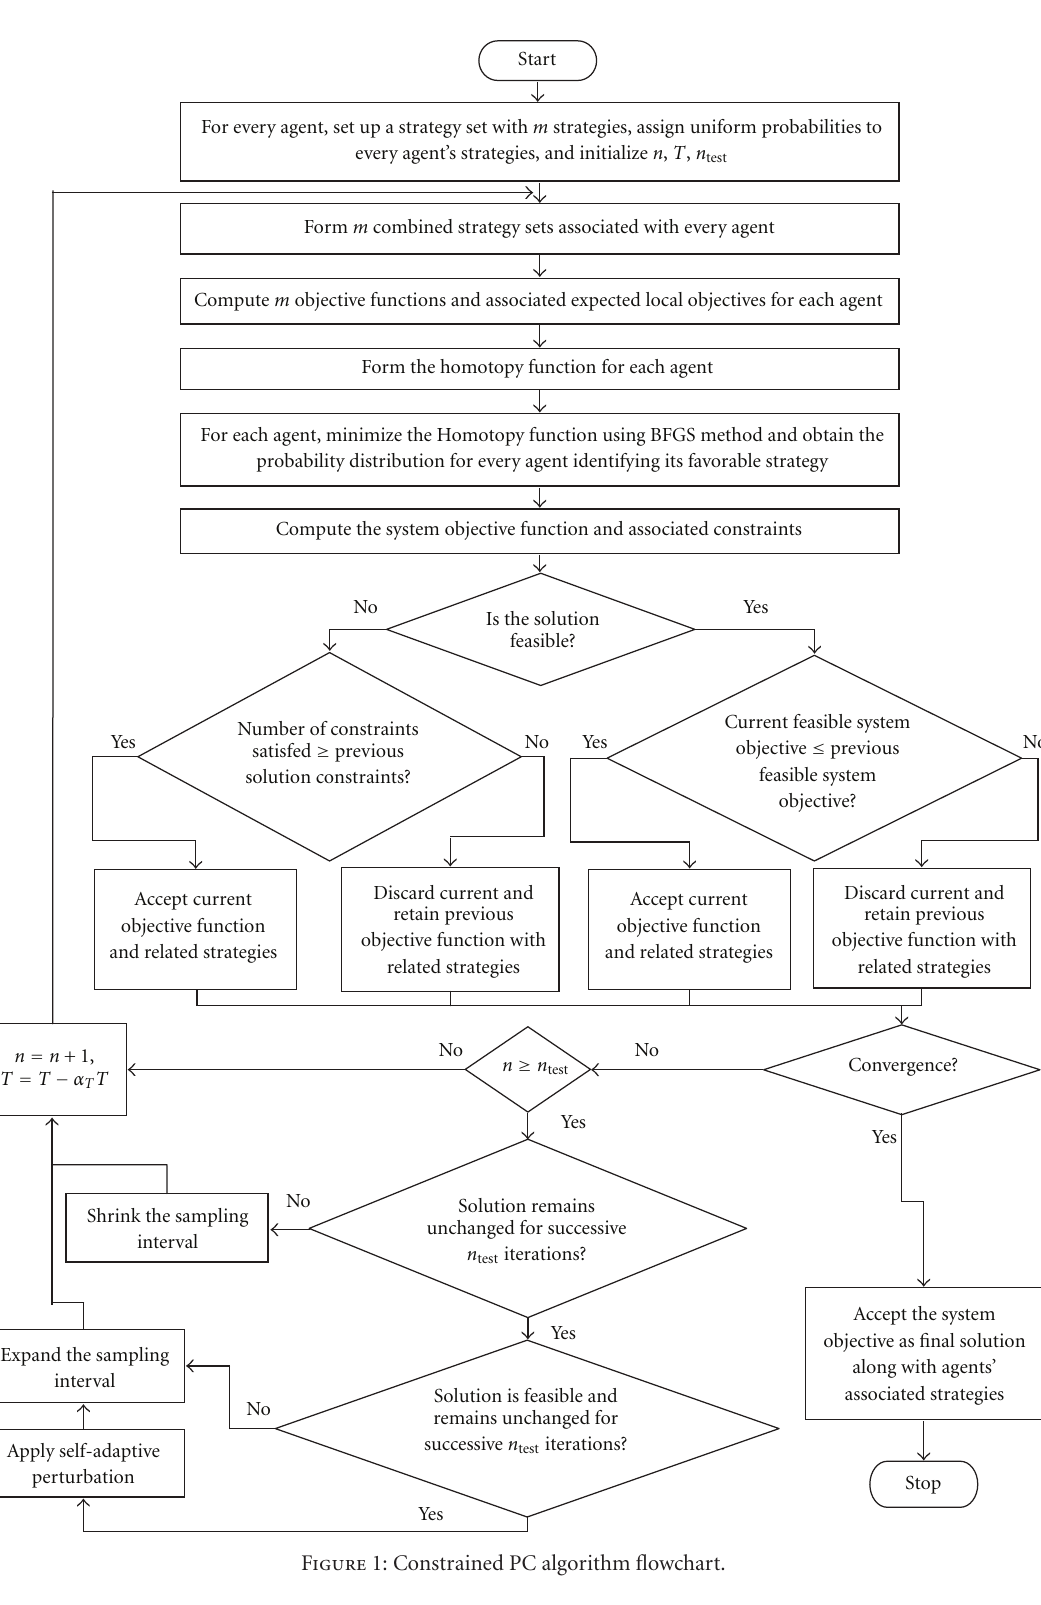
Figure 1: Constrained PC algorithm